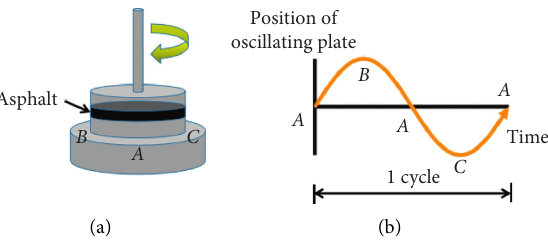
Figure 4: Configuration and load cycle of dynamic shear